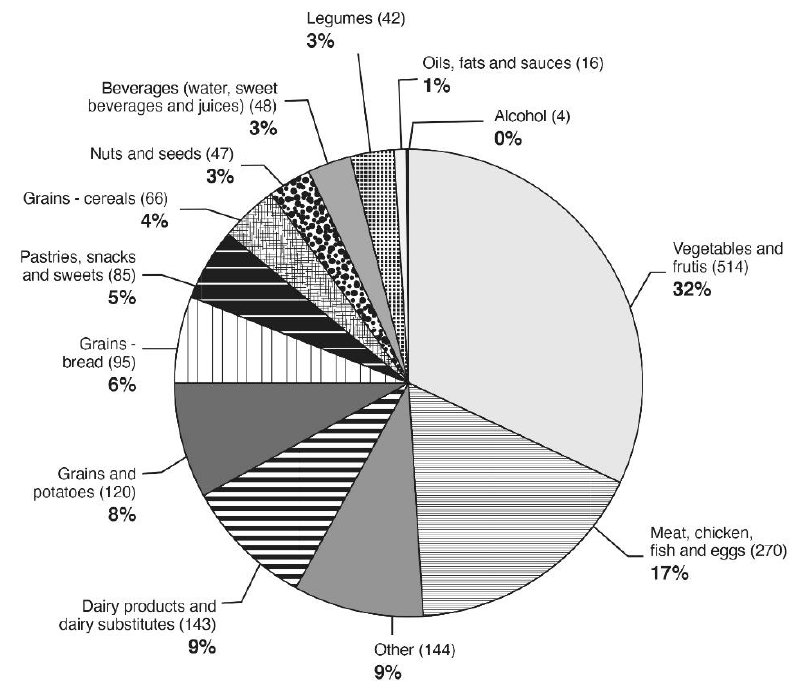
Figure 3. Food groups’ contribution to potassium intake as assessed by 24-h food recall. Table 4. Adjusted linear correlations between electrolytes measurements and metabolic syndrome